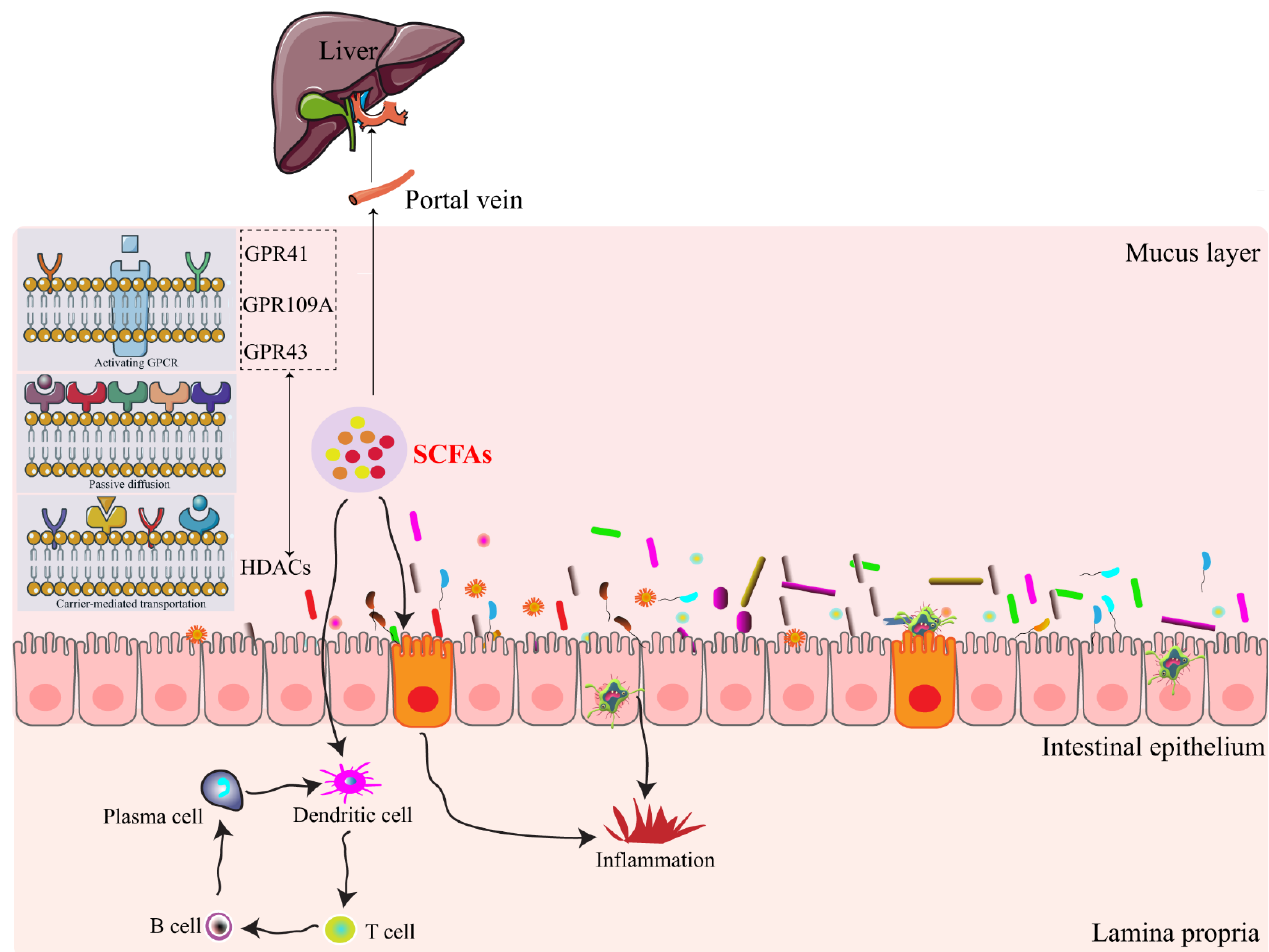
Figure 1. Interactions of short chain fatty acids with intestinal epithelium based on histone deacety- lases (HDACs) and G protein-coupled receptors (GPCRs). Intestinal microbiota-derived metabolites of SCFAs are absorbed in direct or indirect ways. They are then absorbed into the blood vessels and finally enter the liver through the portal vein, as well as interact with the intestinal immune system. GPR41, G-protein coupled receptor 41; GPR43, G-protein coupled receptor 43; GPR109A, G-protein coupled receptor 109A.